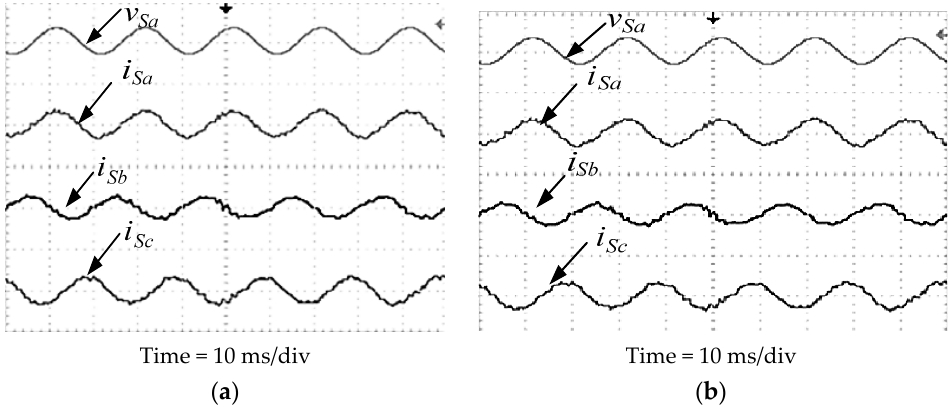
Figure 18. Steady-state experimental results which include the phase a source voltage v Sa (200 V/div) and three-phase source current i Sa , i Sb , and i Sc (20 A/div), resulting from SAPF ( a ) with FLC and ( b ) without FLC.